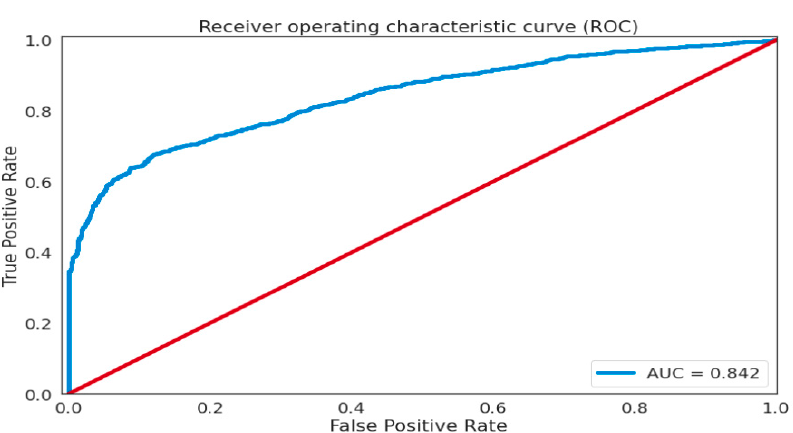
Figure 4. Different classes depicting reconstruction error.